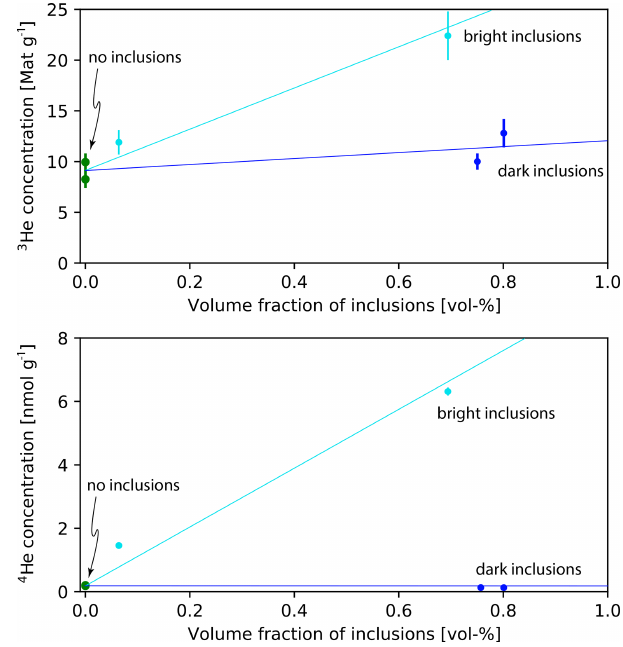
Figure 10. The effect of bright (turquoise) and dark (dark blue) inclusions on the 3 He and 4 He concentration of magnetite grains compared to aliquots without inclusions (green). Bright inclu- sions (apatite, zircon) contribute large amounts of 3 He and 4 He, whereas dark inclusions (silicates) contribute little 4 He and moder- ate amounts of 3 He. Lines show general trends and are not quanti- tative.